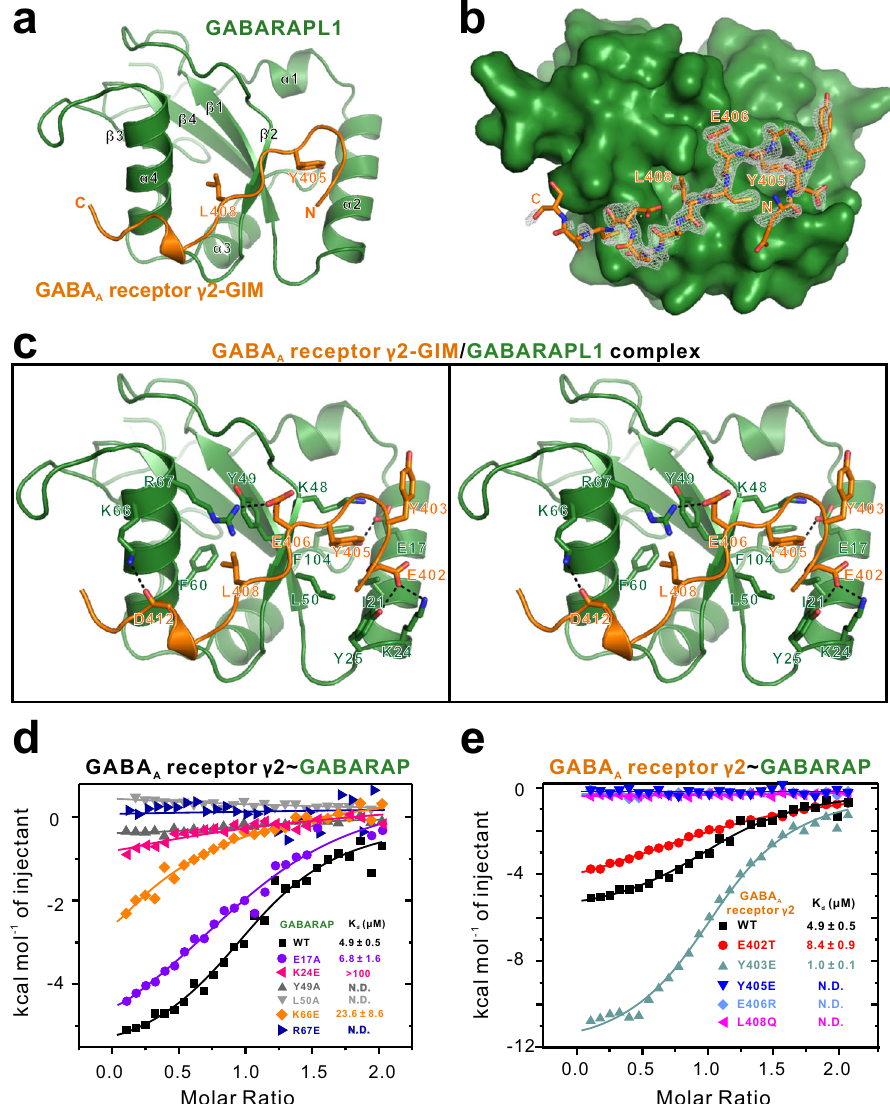
Fig. 2 Overall structure of GABARAPL1 in complex with γ 2-GIM and characterization of key residues at the interface of the GABARAPL1 – γ 2-GIM complex. a Ribbon representation model showing the overall structure of the GABARAPL1 – γ 2-GIM complex. In this drawing, GABARAPL1 is shown in forest green and γ 2-GIM is in orange. The coordinates and structure factors of the GABARAP and γ 2-GABA A R complex have been deposited in the Protein Data Bank with accession number 7CDB. b The F o − F c map of γ 2-GIM showing that the densities of residues 402 – 413 can be clearly assigned. c Stereo view showing the detailed interactions between γ 2-GIM and GABARAPL1. The hydrogen bonds involved in the binding are shown as dotted lines. d ITC-derived binding curves comparing the binding af fi nities between γ 2-GIM and GABARAP or its six mutant variants (E17A, K24E, Y49A, L50A, K66E, and R67E). e ITC-derived binding curves comparing binding af fi nities between GABARAP and γ 2-GIM or its fi ve mutant variants (E402T, Y403E, Y405E, E406R, and